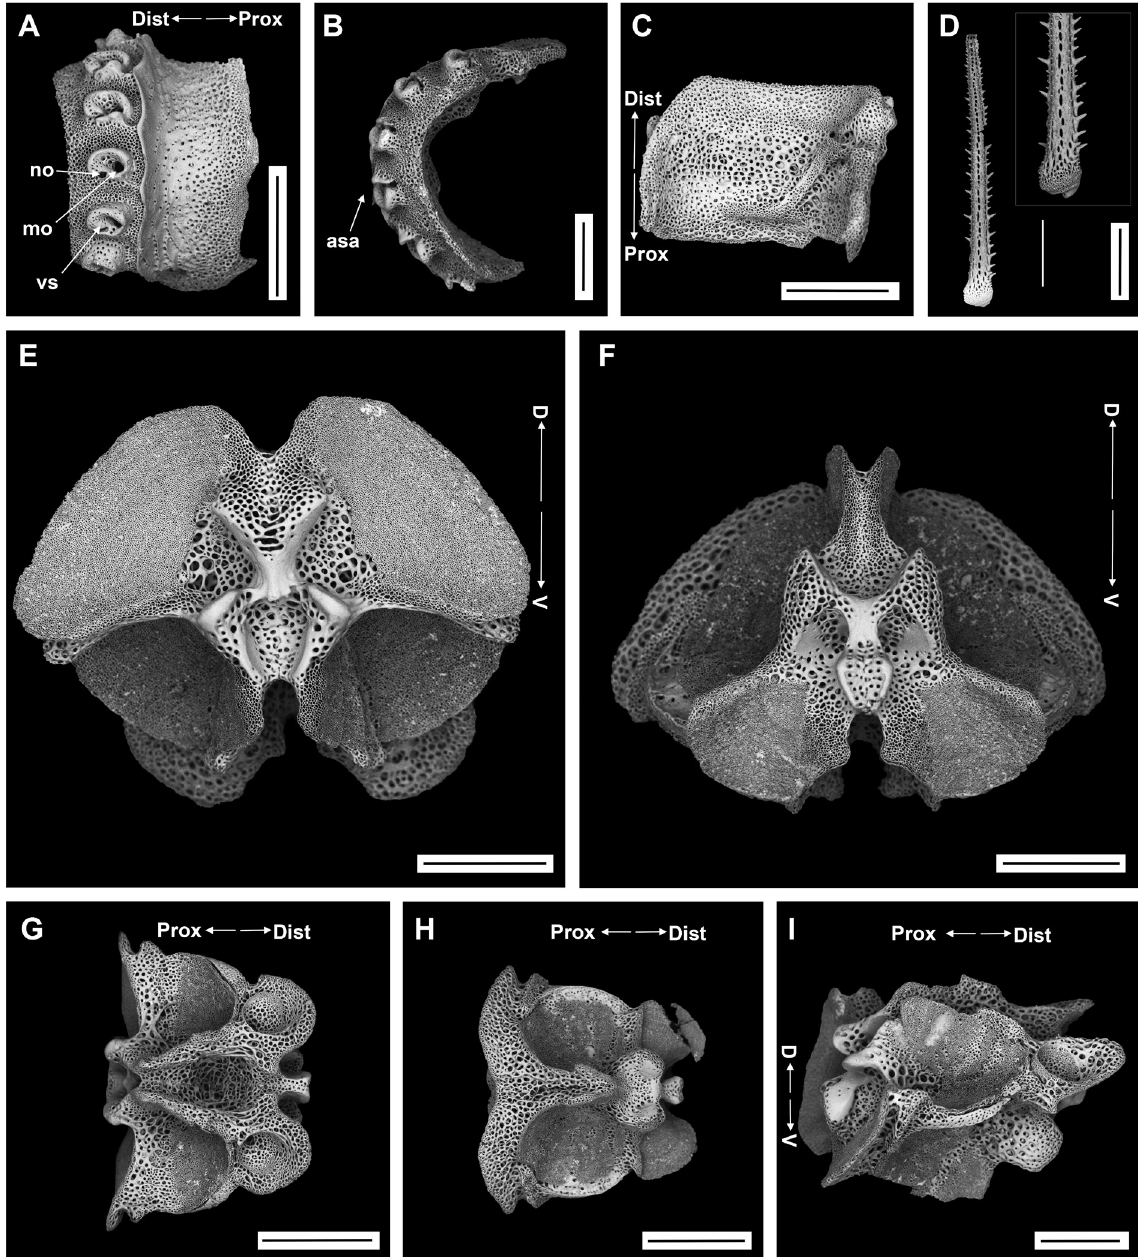
Fig. 19. Ophiopristis shenhaiyongshii sp. nov., SEM, holotype (IDSSE EEB-SW0022). A–C . Lateral arm plate. D . Dorsal arm spine. E–I . Vertebrae. E . Proximal view. F . Distal view. G . Ventral view. H . Dorsal view. I . Lateral view. Abbreviations: asa = arm spine articulation; D = dorsal; Dist = distal; mo = muscle opening; no = nerve opening; Prox = proximal; V = ventral; vs = volute-shaped. Scale bars: A, G–H = 500 µm; B–F, I = 300